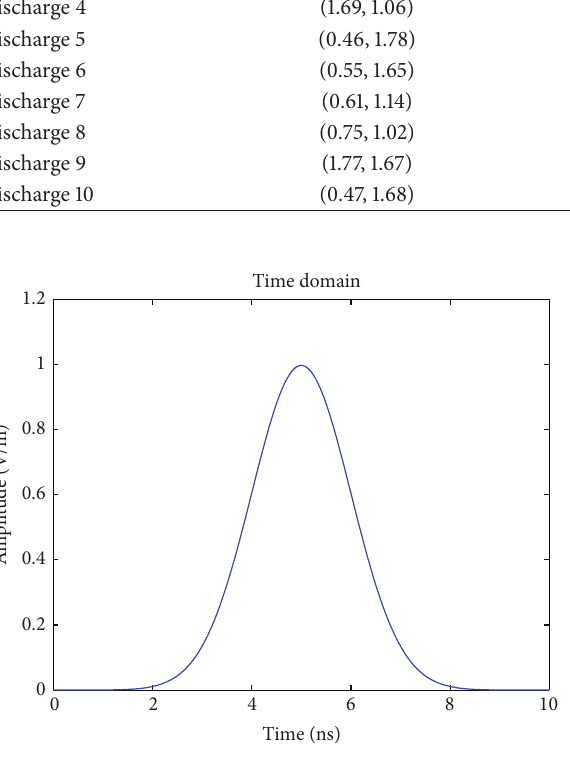
Figure 3: Waveform of partial discharge voltage pulse.